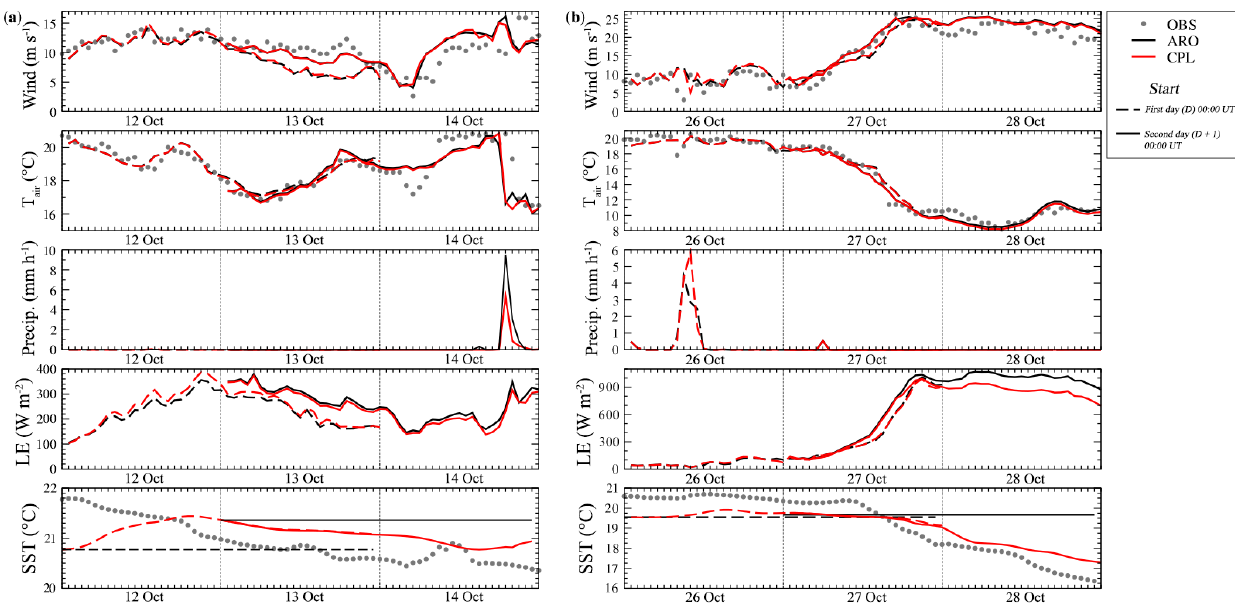
Figure 5. Time series of wind (first row), temperature at the first atmospheric level (second row), surface precipitation rate (third row), latent heat flux (fourth row) and SST (fifth row) at the LION buoy in CPL (red line) and ARO (black line) during (a) IOP13 (forecasts of 12 October 2012) and (b) IOP16b (forecasts of 26 and 27 October 2012), compared to in situ observations when